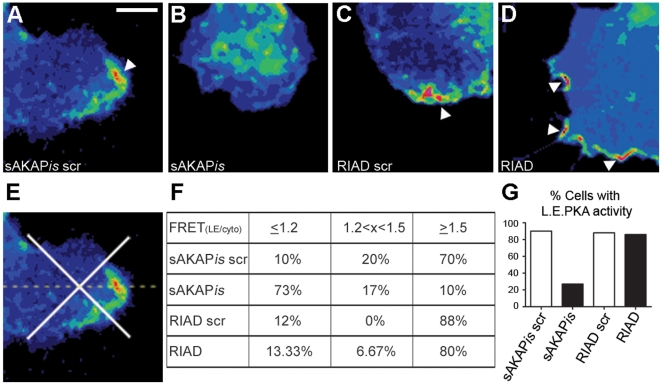
Leading edge PKA activity is mediated by RII-AKAP interactions.(A-D) SKOV-3 cells co-expressing the indicated plasmids in conjunction with pmAKAR3 were subject to the donut migration assay for 10 hr and imaged via widefield fluorescent microscopy and FRET microscopy. Representative pseudocolored FRET images of cells co-expressing mCherry fused to (A) scrambled superAKAPis (sAKAPis scr), (B) superAKAPis (sAKAPis), (C) scrambled RIAD (RIAD scr), or (D) RIAD are shown. White arrow heads point to leading edge PKA activity. Scale bar = 10 µm. (E) To quantify the percent of cells exhibiting leading edge PKA activity, the cells were divided into leading edge, cytoplasmic, right and left quadrants, and a ratio of the FRET ratio values was generated via linescan analysis through the highest intensity pixels within the leading edge. (F) The tabulated results of cells exhibiting leading edge PKA activity is shown as the percentage of cells displaying low (≤1.19), medium (1.2<x<1.5), or high (≥1.5) LE/Cyto FRET ratios. (G) shows a graphical representation of the tabulated data where cells are scored as having leading edge PKA activity if the LE/Cyto FRET ratios are >1.2 (n = 15 from three separate experiments).